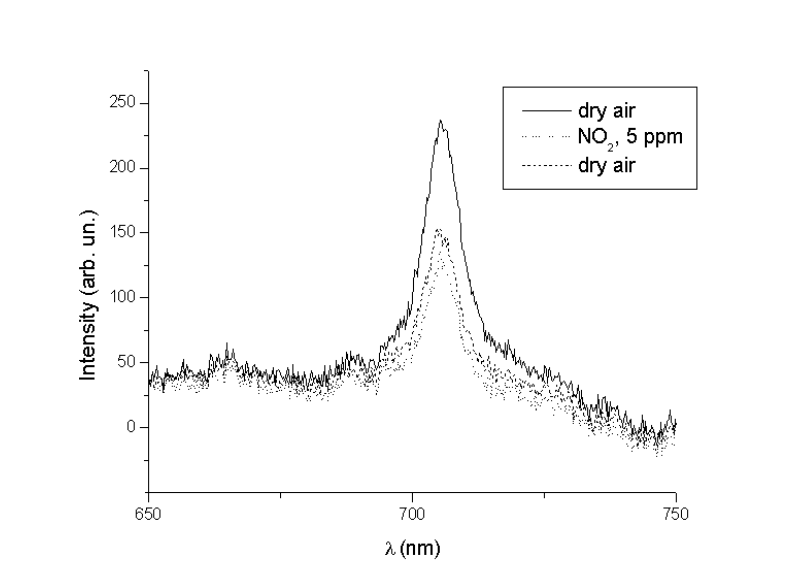
Figure 2. PL spectra of a p + PSM, under a controlled flow of dry air (solid line), dry air + NO (5 ppm, dash-dotted line), and back to dry air (dashed 2